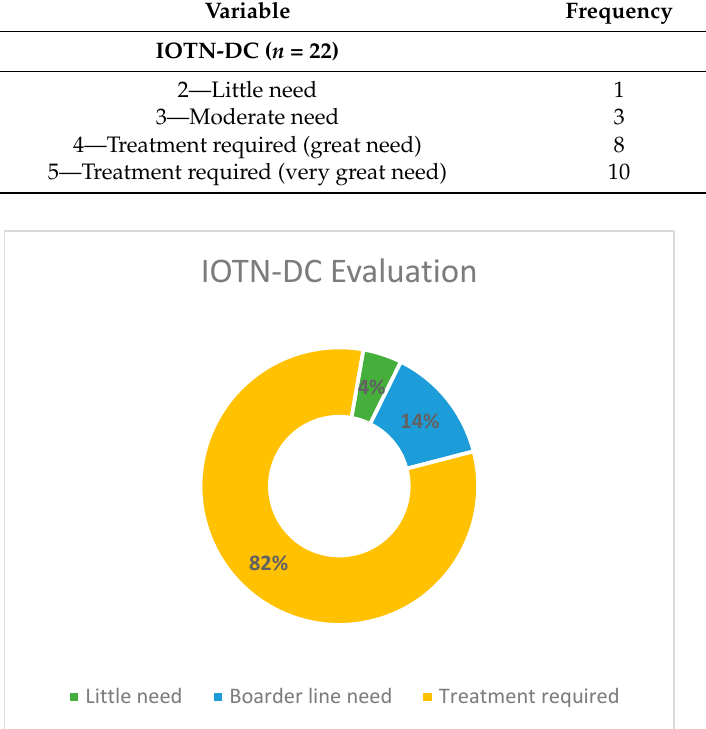
Table 3. Orthodontic Assessment Results.